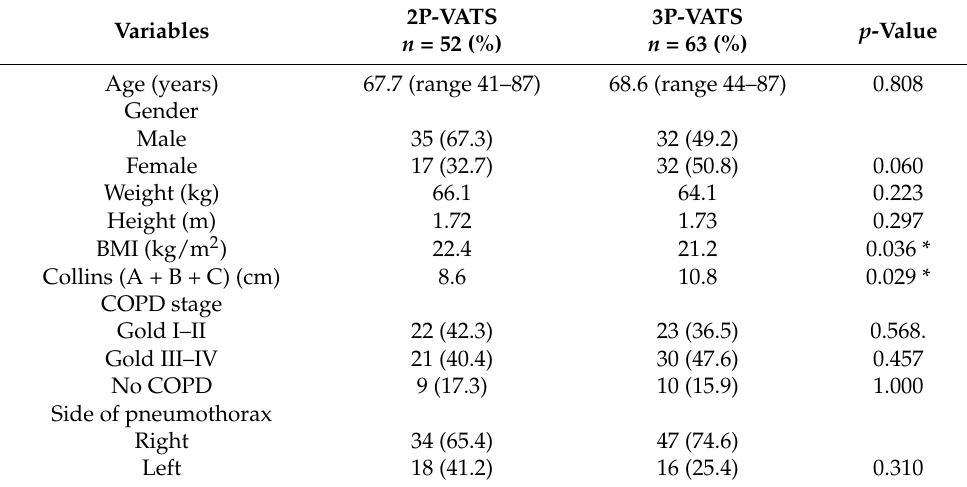
Table 1. Patient